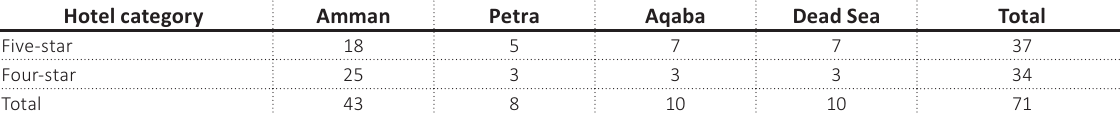
Table 2. Number of five and four-star hotels in main cities in Jordan 2019